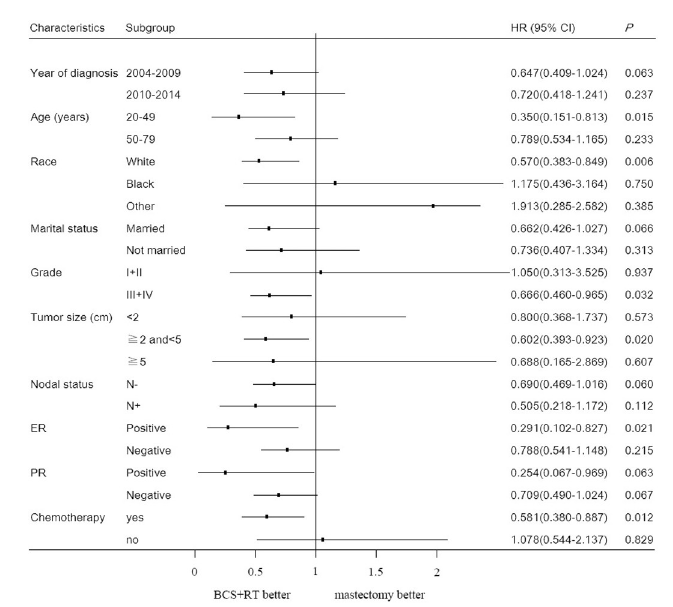
Fig 2. The forest plot for HR comparing OS between the BCS+RT group and mastectomy group according to different